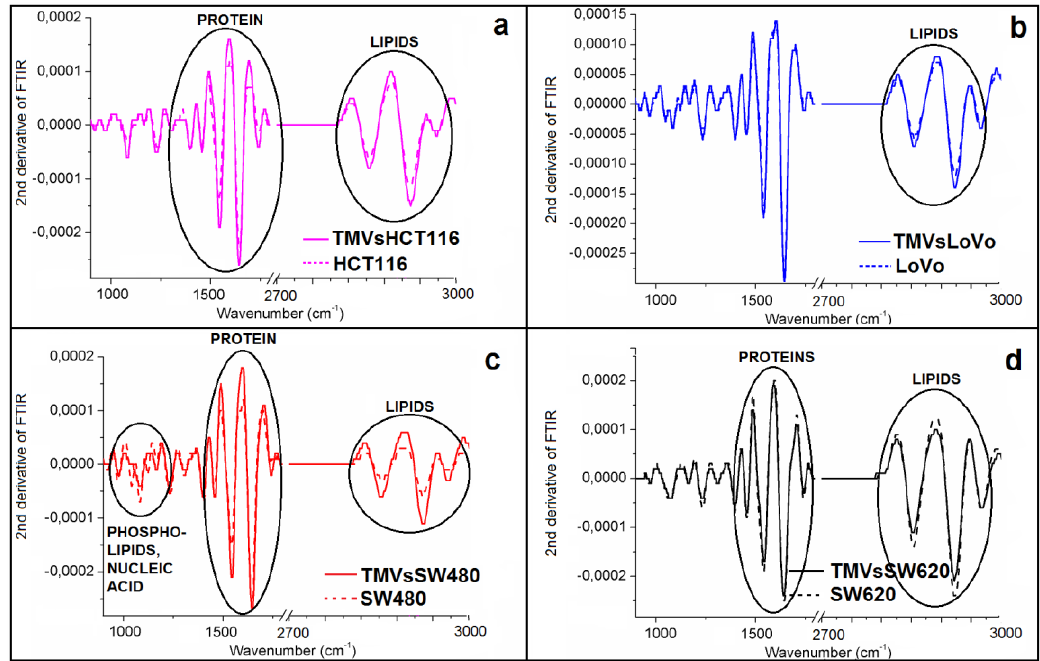
Figure 5. Second derivative of the FTIR spectra of: ( a ) HCT116; ( b ) LoVo; ( c ) SW480 and ( d ) SW620 cell lines (dashed lines) and of: ( a ) TMV HCT116 ; ( b ) TMV LoVo ; ( c ) TMV SW480 and ( d ) TMV SW620 (full lines).